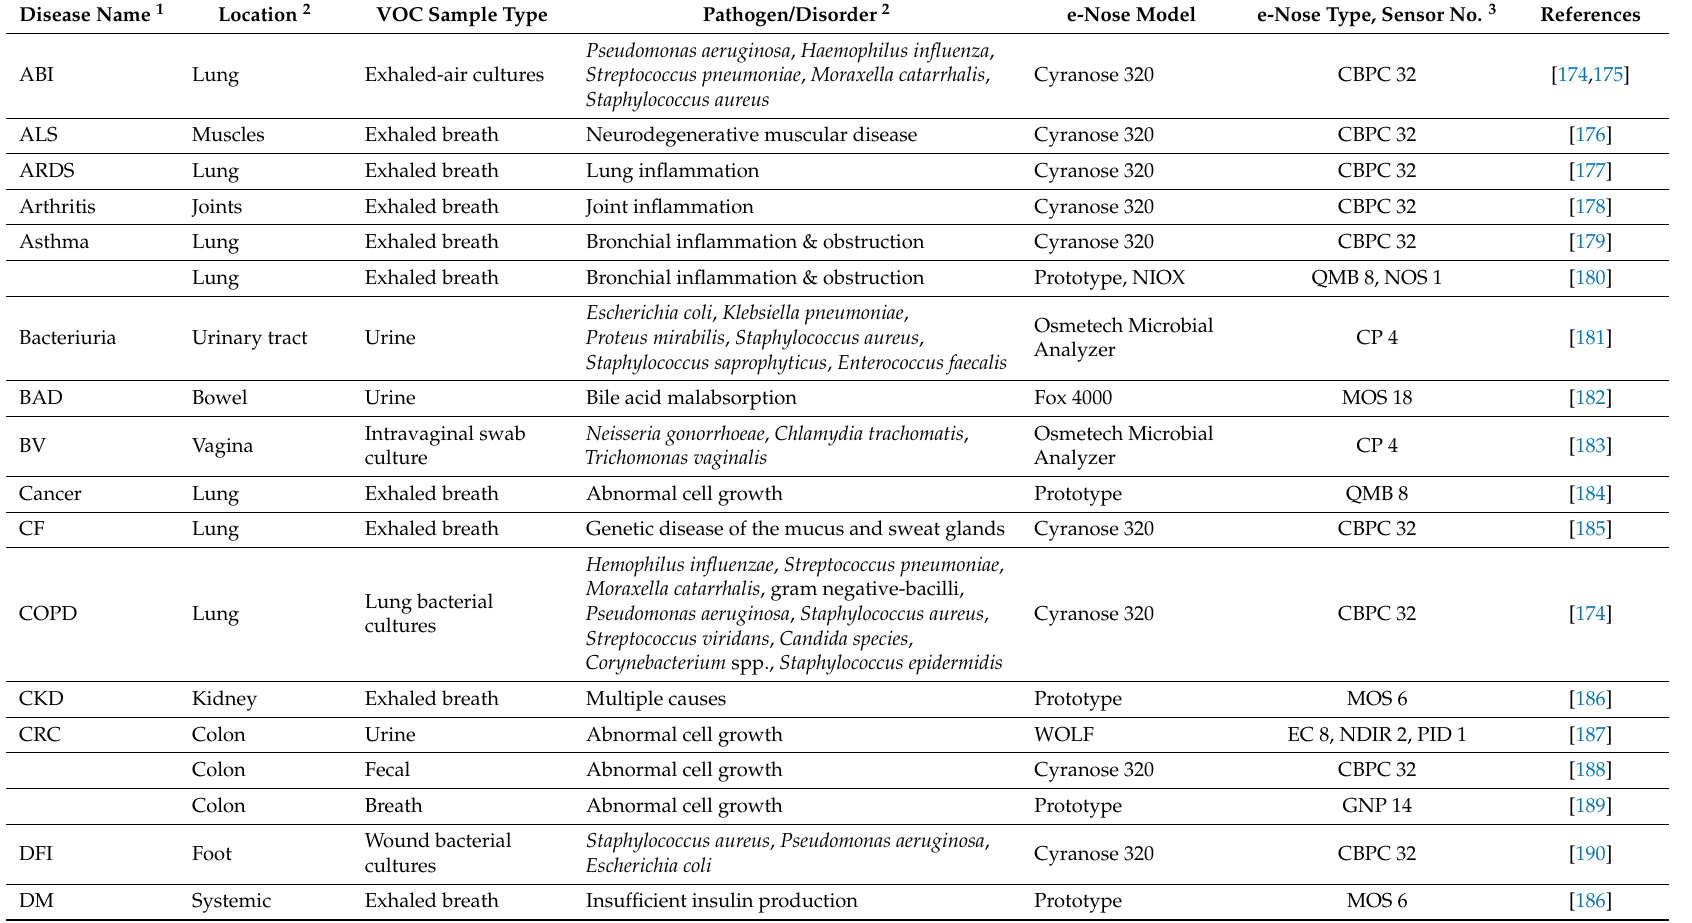
Table 4. Clinical applications of electronic-nose devices for detection of human diseases in Point-Of-Care (POC)